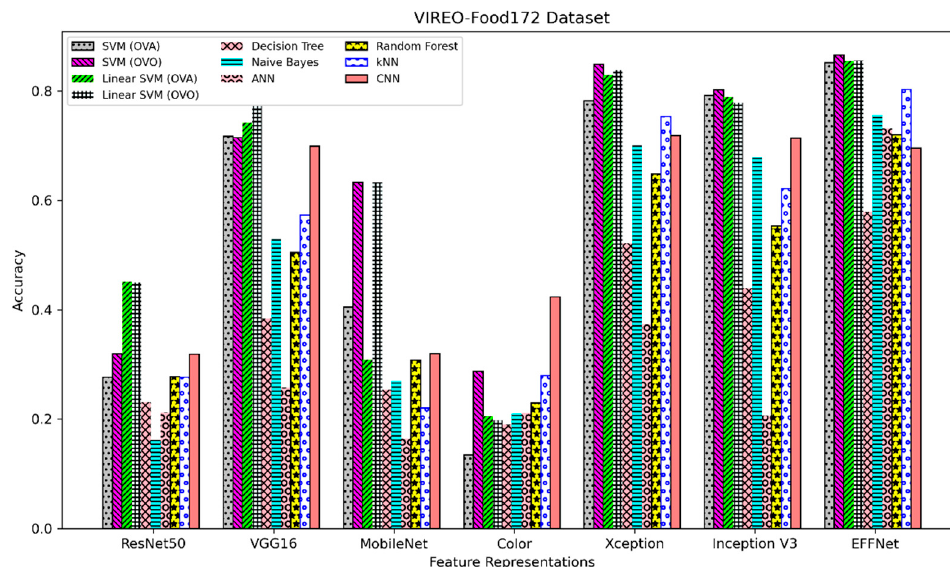
Figure 4. A comparison of the performance of six feature representations and ten classifiers on the VIREO-Food172 Dataset.